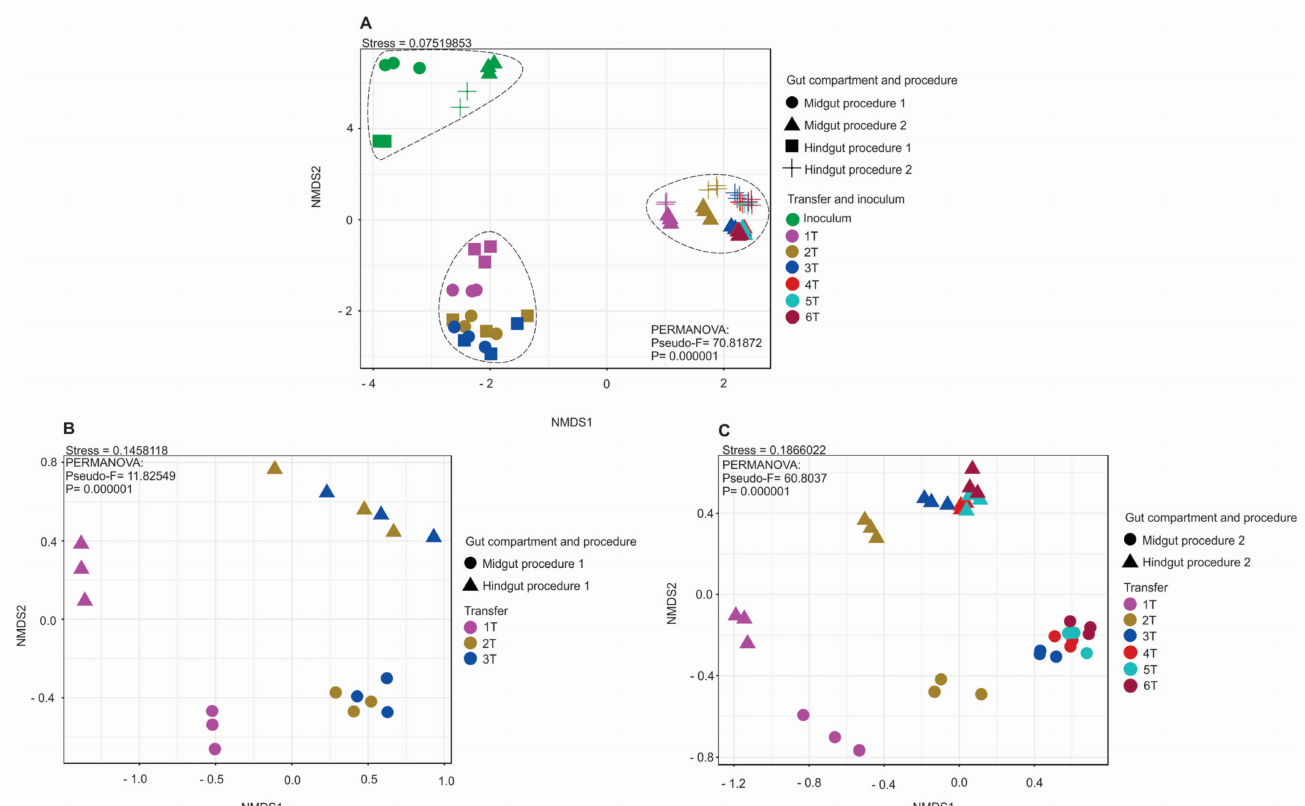
Figure 2. NMDS plots based on 16S rRNA gene amplicon sequences using the Bray-Curtis dissimilar- ity index and permutational multivariate analysis of variance (PERMANOVA) ( n = 3). Statistics are provided as inset panels. ( A ) Inoculum, enrichment cultures of P1 and P2. ( B ) Only samples from enrichment cultures of P1 and ( C )